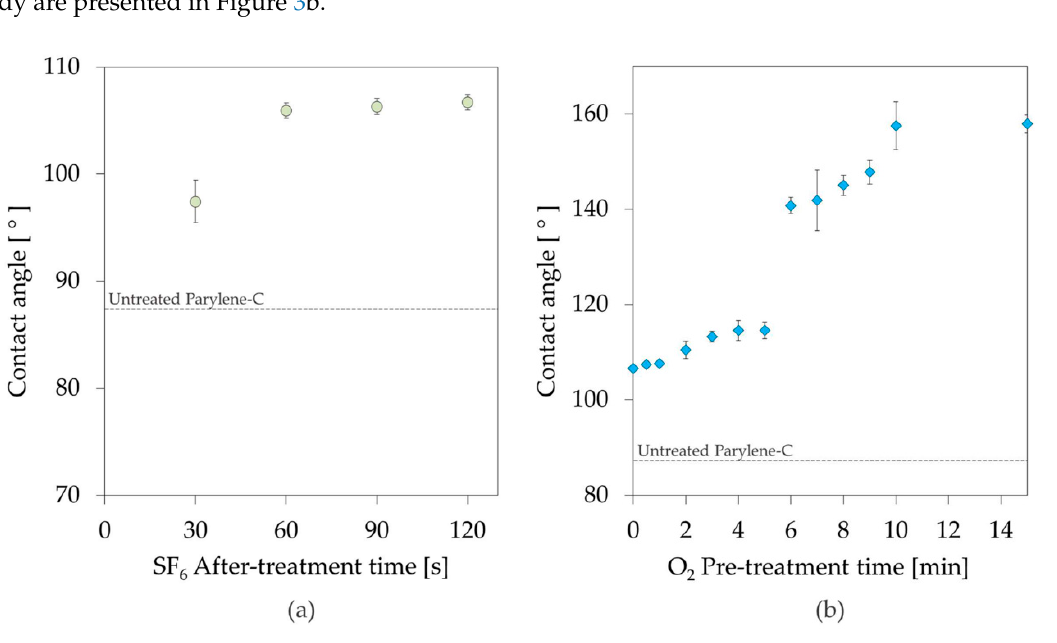
Figure 3. Static contact angle of DI water on Parylene-C coated glass slides as a function of: ( a ) SF 6 after-treatment time (all samples were previously exposed to 30 s O 2 plasma) and ( b ) O 2 pre-treatment time (all samples were subsequently exposed to 60 s SF 6 plasma). The error bars represent the standard deviation between three different measurements.